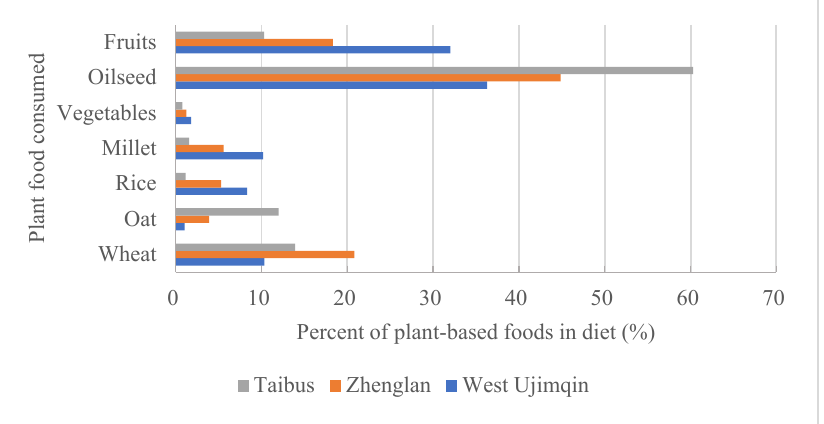
Figure 5. A comparison of animal-based food consumption ratios among the three banners. Plant-based food consumption in these three banners was mainly represented by wheat, oats, rice, millet, oilseed, vegetables, and fruits. The most prominent proportion in Taibus was for oilseed, at 60.28% (Figure 6), which was much higher than that in the other two banners and was the highest contributor to the total plant-based food consumption. The highest consumption rate for oats appeared in the same banner as that for oilseed, but the highest consumption rate of oats was 12.01%, trailing far behind the rate for oilseed. The greatest consumption rates of rice, millet, vegetables, and fruits all appeared in West Ujimqin banner, and the least ones were found in Taibus banner. Different from other kinds of food consumption rates, the greatest rate for wheat, 20.82%, appeared in Zhenglan banner. The consumption rates of wheat in the other two banners were both more than 10%.